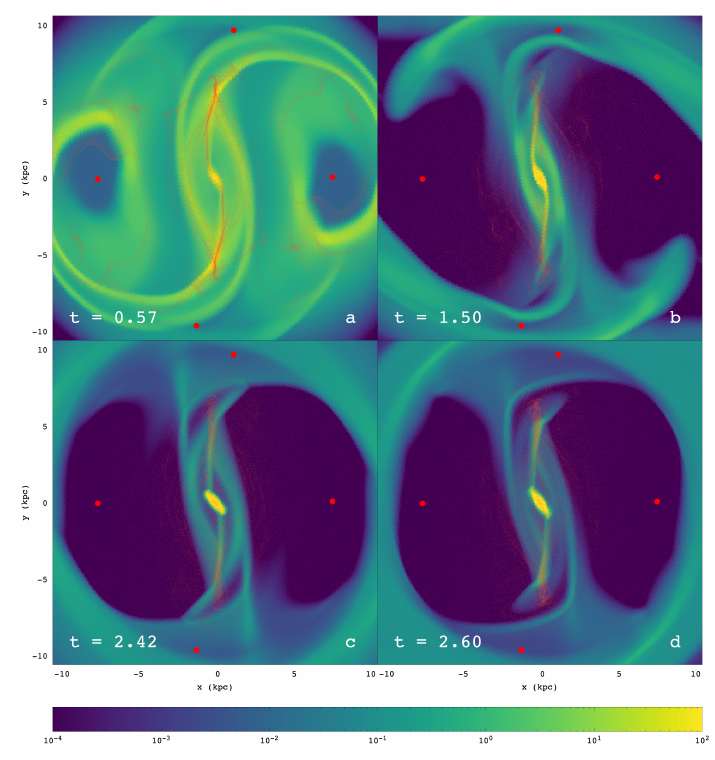
Figure 12. The evolution of a typical RAMSES model, with c s = 5km s − 1 . The snapshot in ( a ) is in the growing bar phase, while in ( b – d ) the bar perturbation has already reached its maximum. Times are given in the lower-left corner of the frames. Densities increase from left to right according to the logarithmic scale of the color bar at the bottom of the figure. In red, we plot the stellar response particles at the corresponding times. The bar rotates counterclockwise. Red dots indicate the location of the Lagrangian